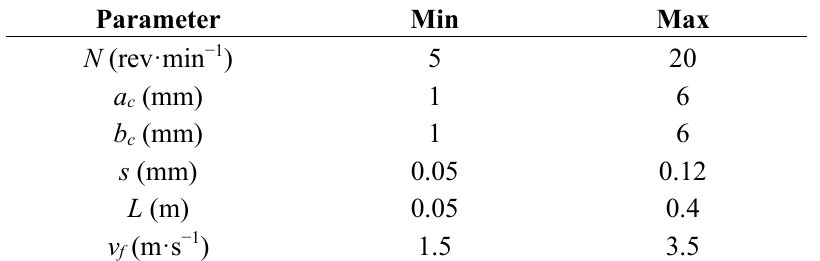
Table 3. Minimum and maximum value of each parameter adopted in the simulations. Parameter Min